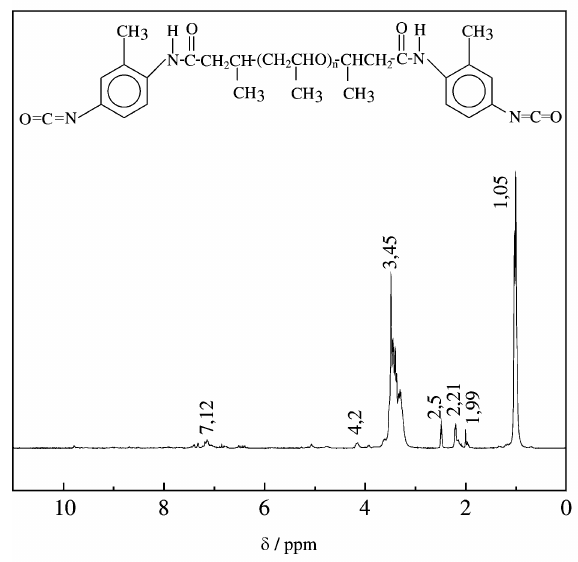
Figure 3. 1 H-NMR spectrum of toluene poly(propylene oxide) diisocy- anate.